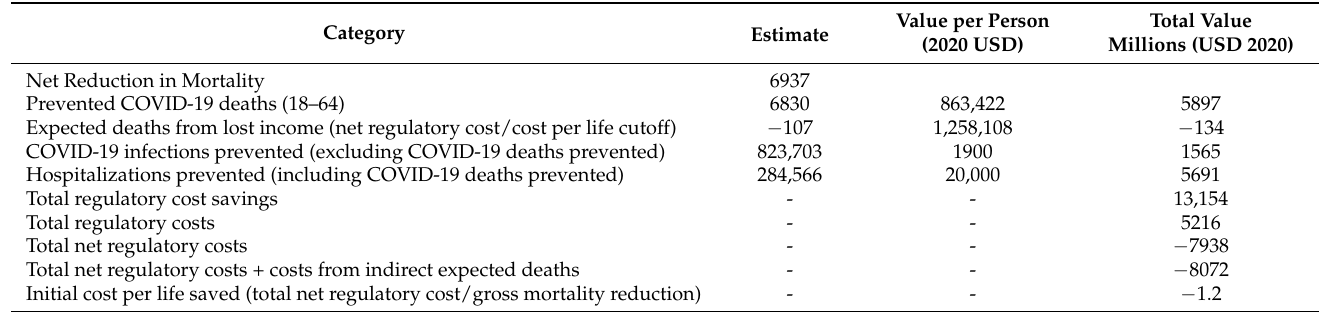
Table 4. Initial Period Costs, Cost Savings and Total Net Costs of OSHA’s COVID-19 Vaccination and Testing; Emergency Temporary